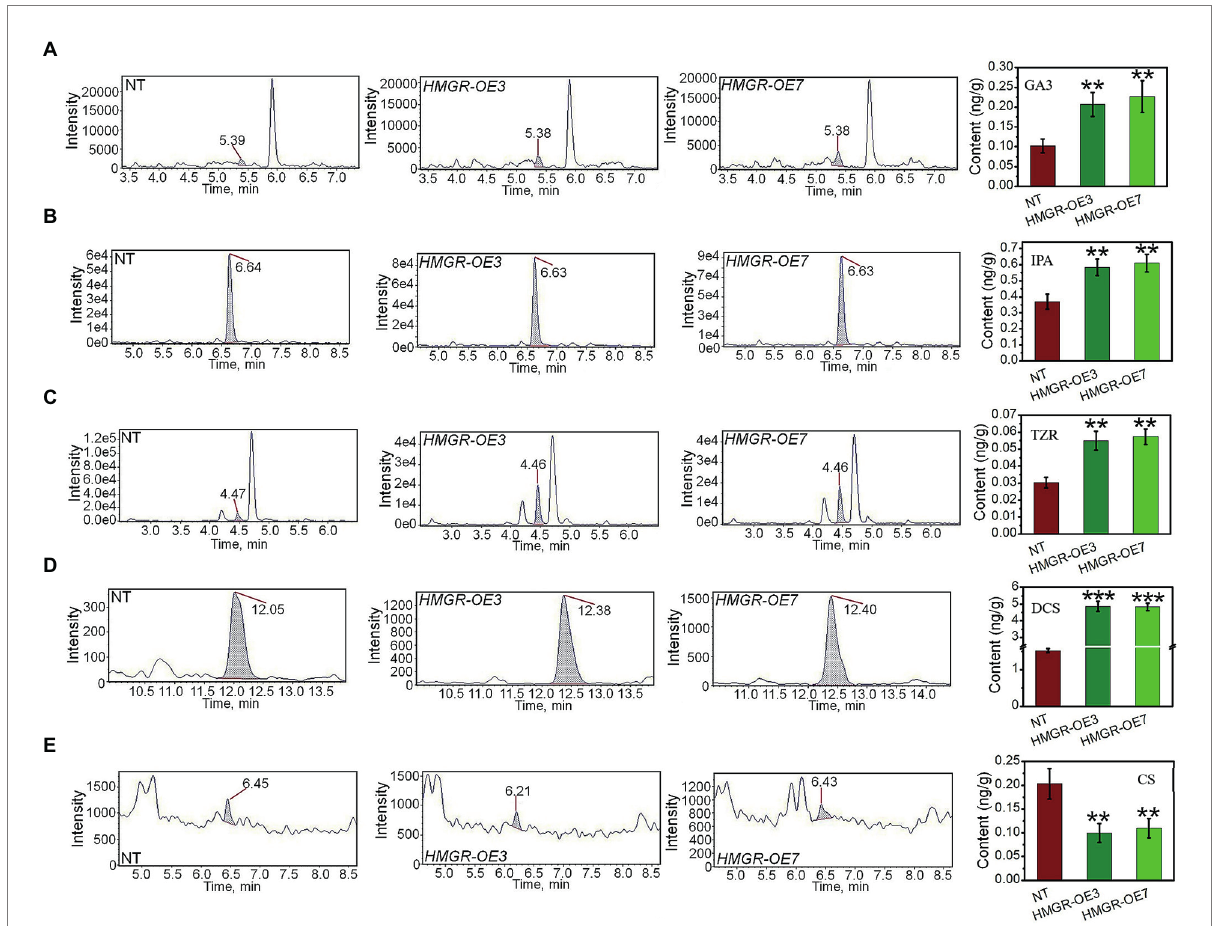
FIGURE 3 Analyzing the effect of the overexpression of PtHMGR on MVA and MEP-derivatives. HPLC-MS/MS analyses of the contents of GA 3 (A) , IPA (B) , TZR (C) , DCS (D) , and CS (E) in PtHMGR - OEs compared to NT poplars. Bars represent mean ± SD ( n = 3); Stars reveal significant differences, ** p < 0.01, *** p < 0.001; Experiments were performed in